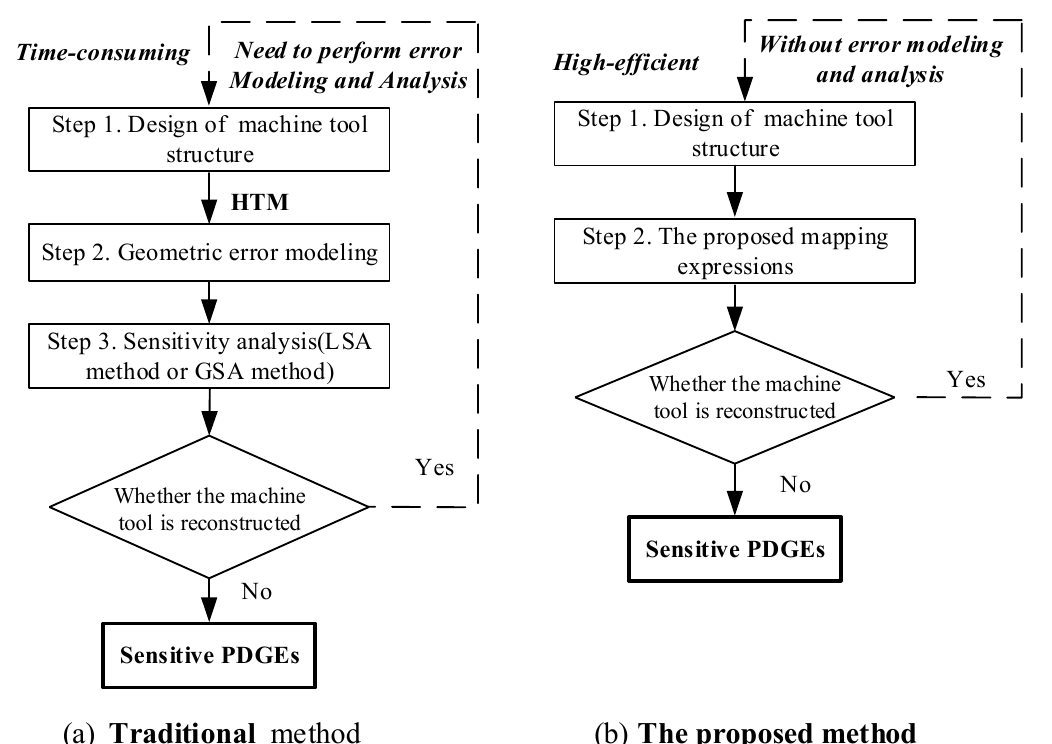
Figure 3. The process of identifying the sensitive geometric errors of the five-axis reconfigurable machine